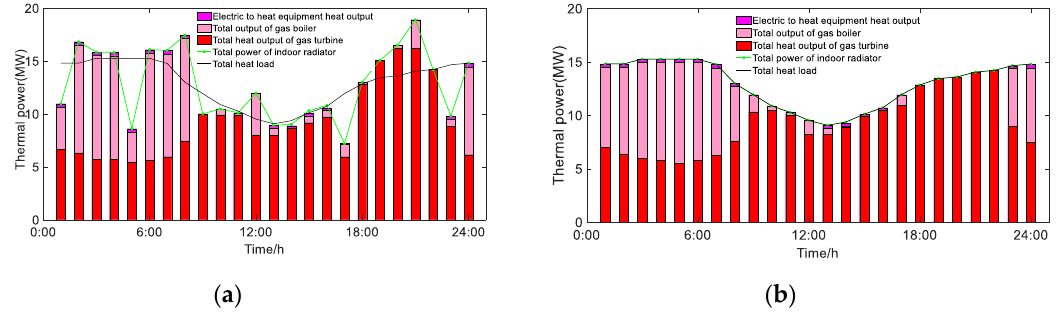
Figure 20. Heat power balance. ( a ) T c = 4 h. ( b ) T c = 1